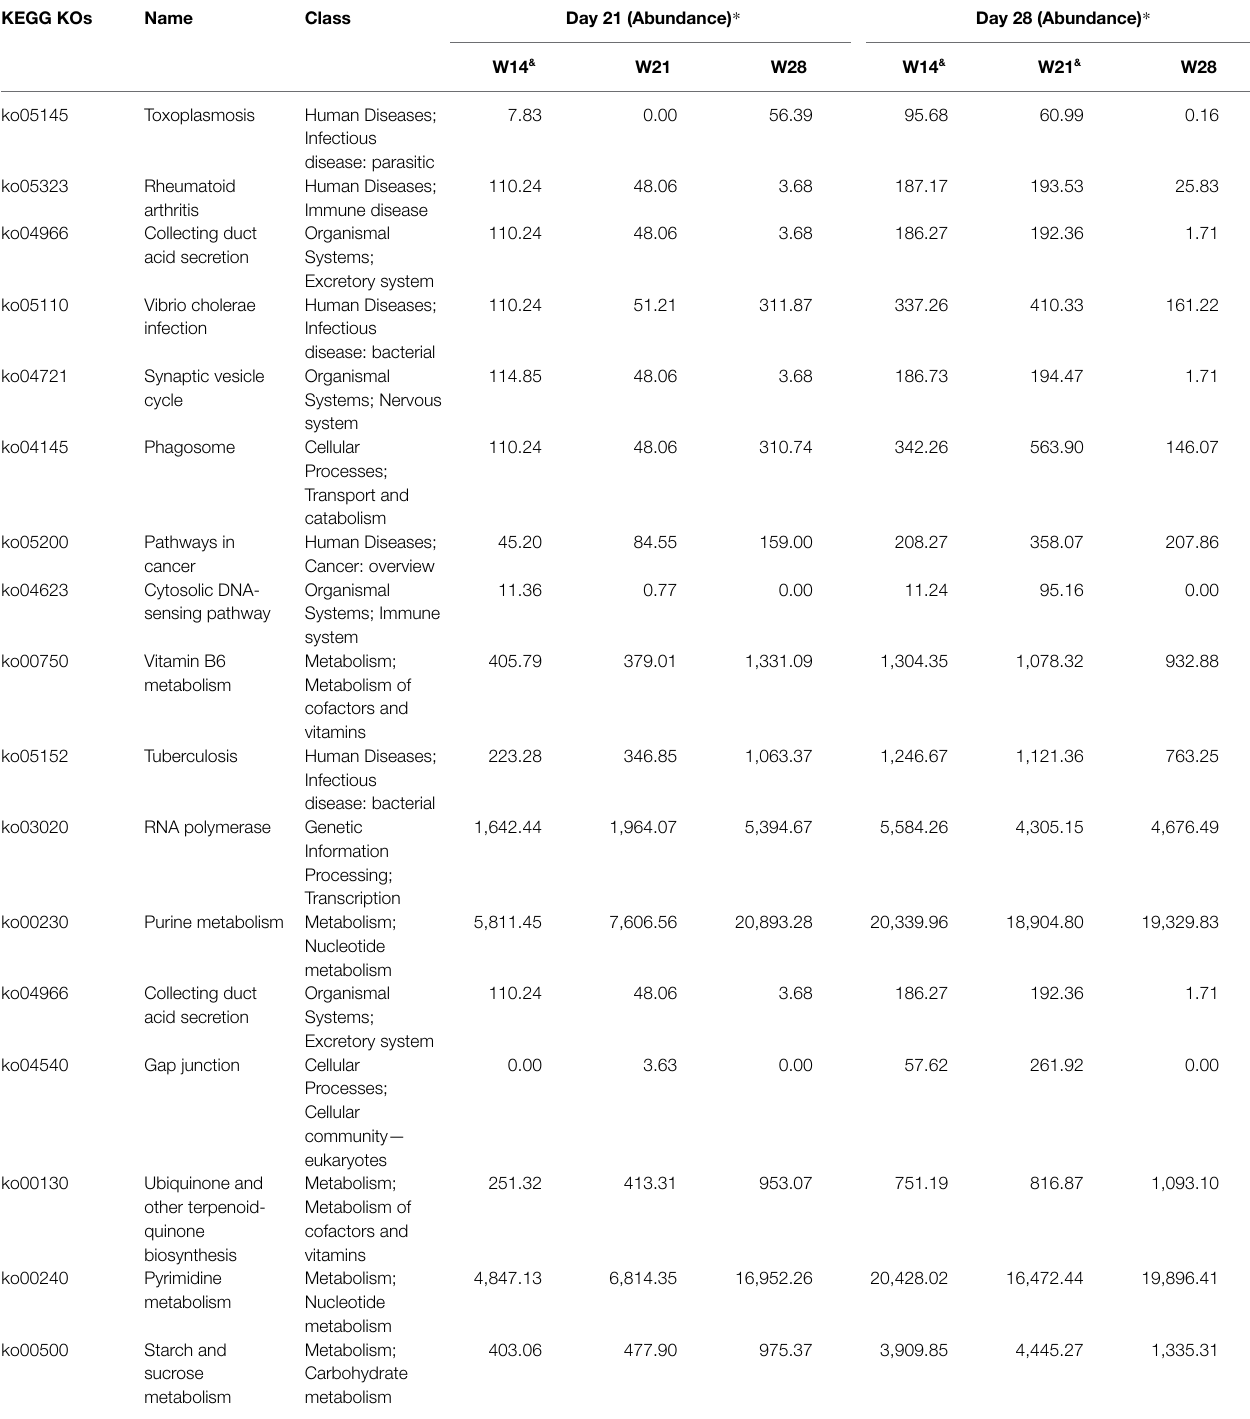
TABLE 1 | KEGG KOs enriched in weaning group on day 21 and 28 by the LefSe